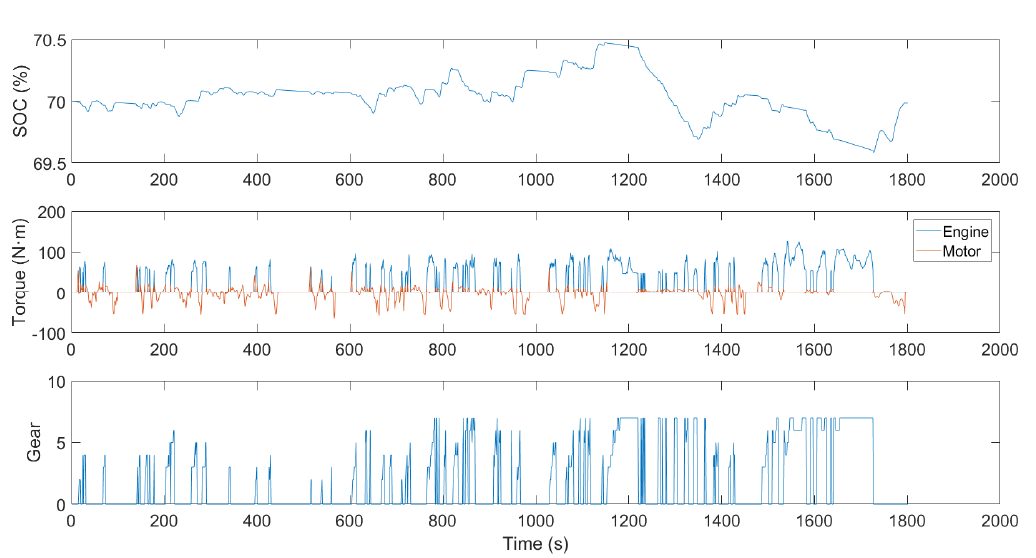
Figure 12. Three state parameters’ variation curves of µ min for emission particle. Energies 2019 , 6 , x FOR PEER REVIEW